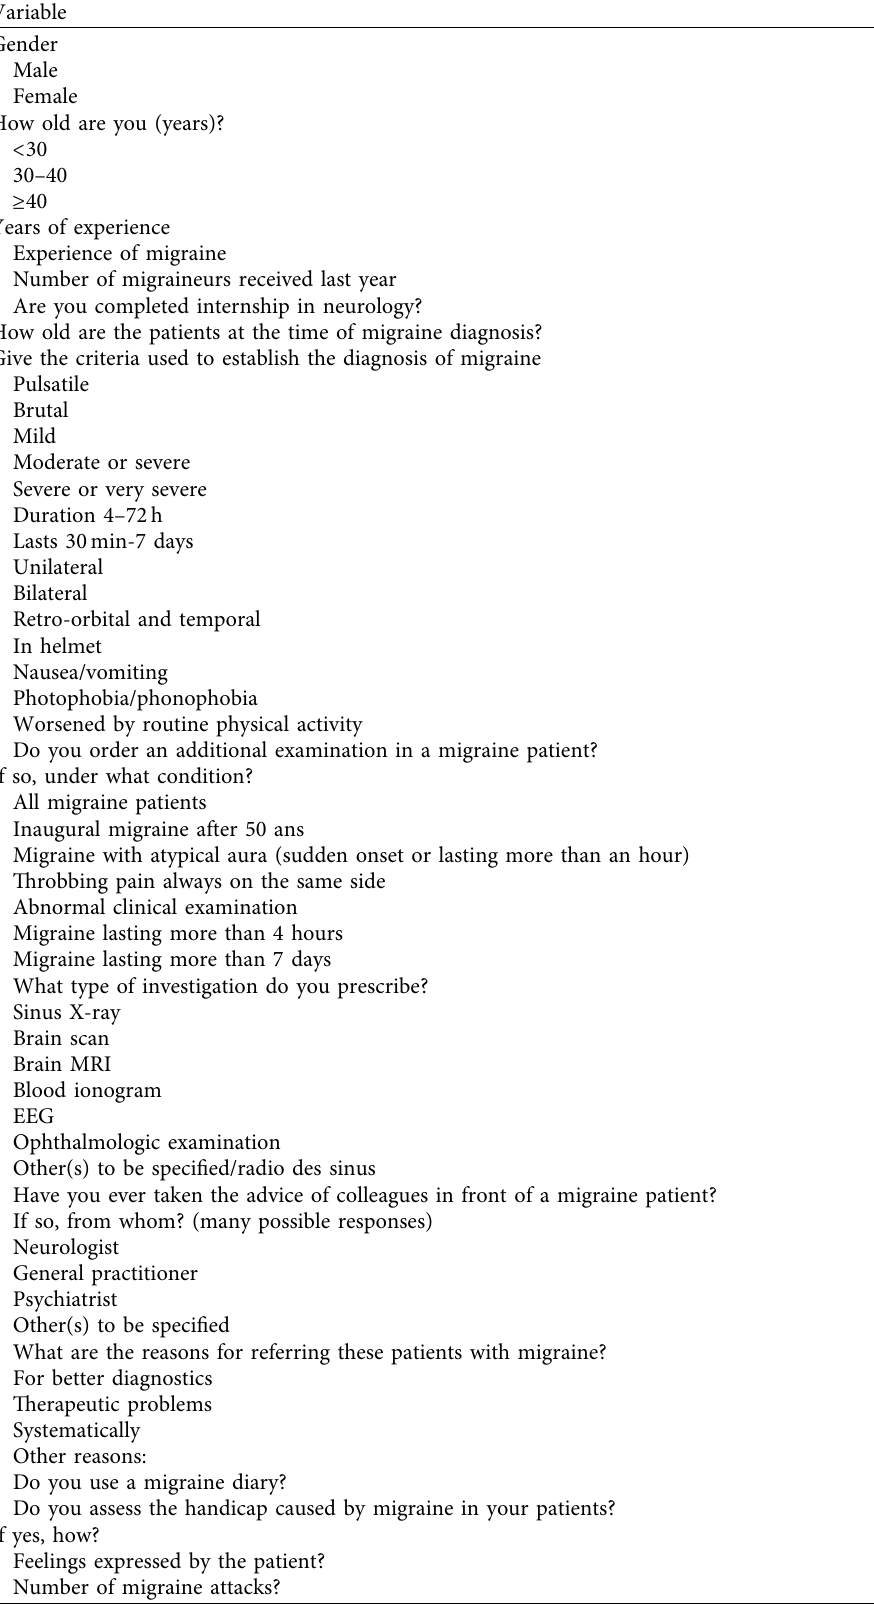
Table 4: Full version of the